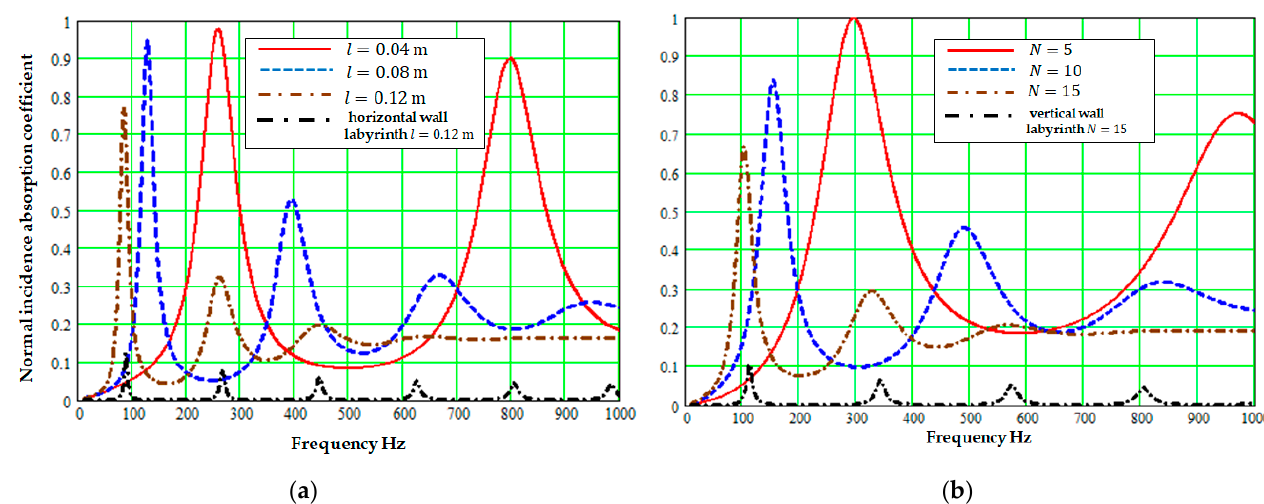
Figure 5. Normal incidence absorption coefficient spectra predicted for 0.05 m thick hard ‐ backed layer composed from a inclined slit matrix (0.04 mm wide slits at 70° to the normal, porosity 0.9) with ( a ) varying wall length in a horizontal ‐ wall labyrinthine slit perforation ( 𝑤 = 1 mm, 𝑏 = 5.1 mm, 𝑁 = 8); 𝑙 = 0.04 m (solid line), 𝑙 = 0.08 m (dotted line), 𝑙 = 0.12 m (dash ‐ dot line) or ( b ) varying slit folding number in a vertical ‐ wall labyrinthine slit perforation ( 𝑤 = 1 mm, 𝑏 = 3 mm, 𝑙 = 45 mm, 𝑁 = 5 (continuous line), 𝑁 = 10 (blue dotted line), 𝑁 = 15 (black broken line). The low absorption dash ‐ dot lines represent predictions for the respective labyrinthine slit perforations in a non ‐ porous solid matrix.